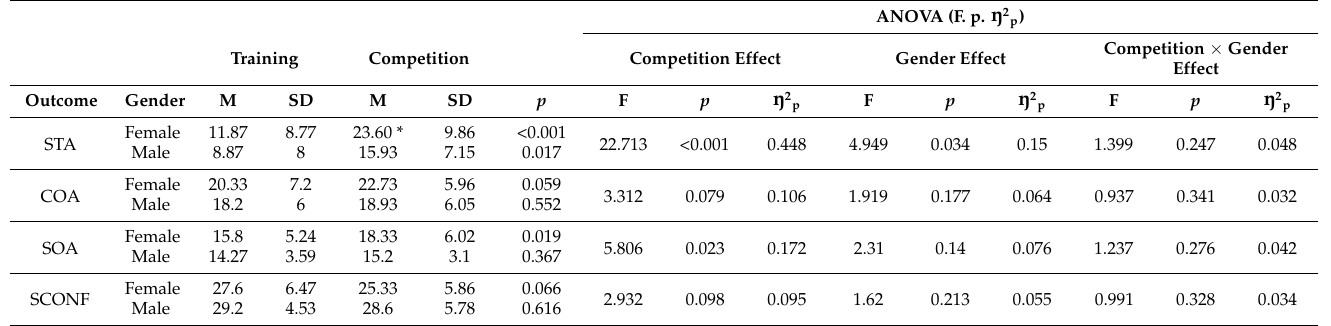
Table 3. Effects of competition and gender on anxiety.